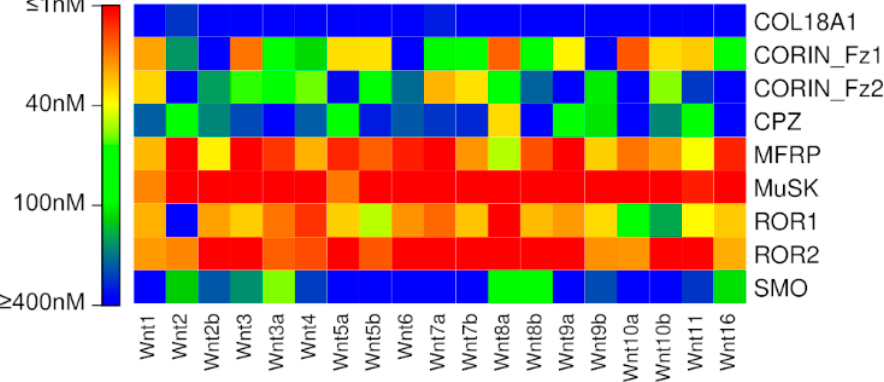
Figure 4. Binding affinities predicted for putative Fzd CRD interactions using the new model. Figure 4. Binding a ffi nities predicted for putative Fzd CRD interactions using the new